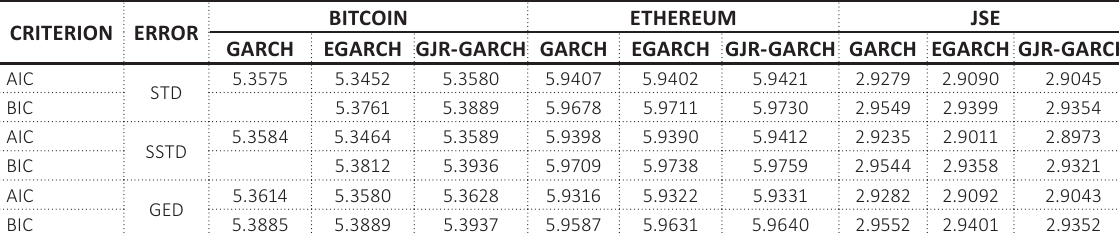
Table 3. Model selection CRITERION